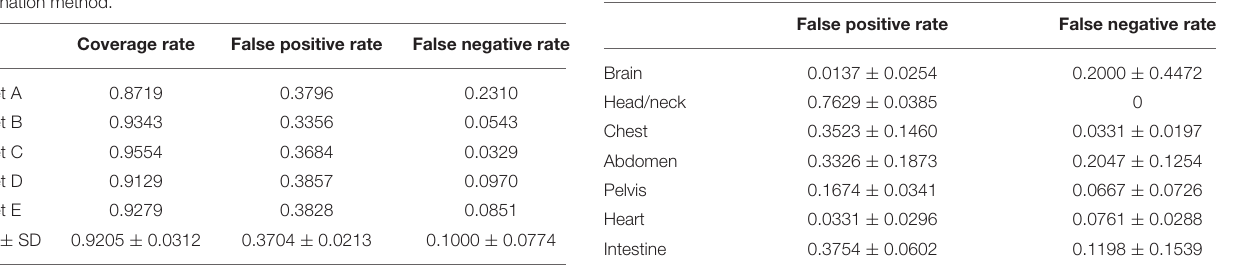
TABLE 2 | False-positive rate and false-negative rate by